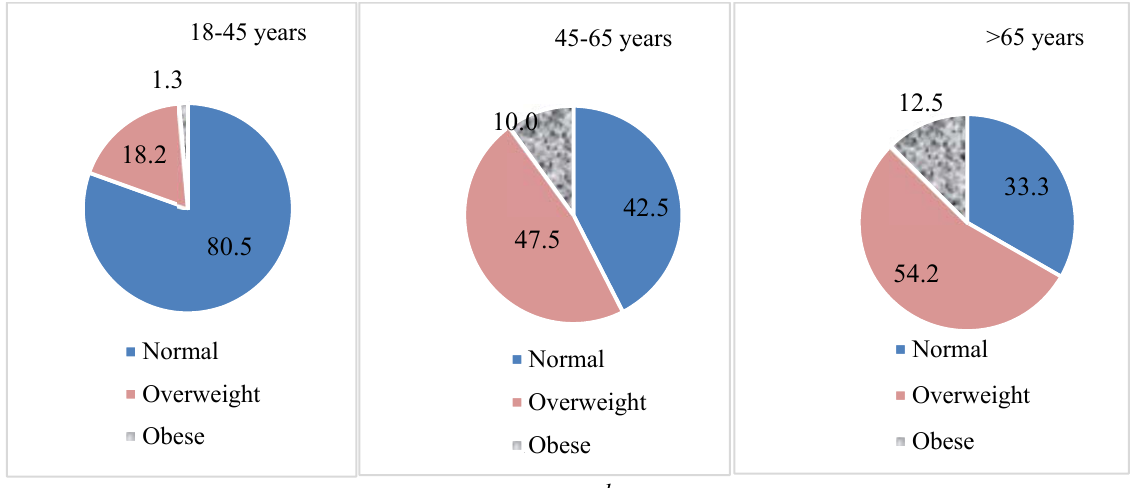
Fig. 1. Body mass index among females (n=141), p=0.000: a – body mass index in the 18–45 years old group; b – body mass index in the 45–65 years old group; c – body mass index in the group above 65